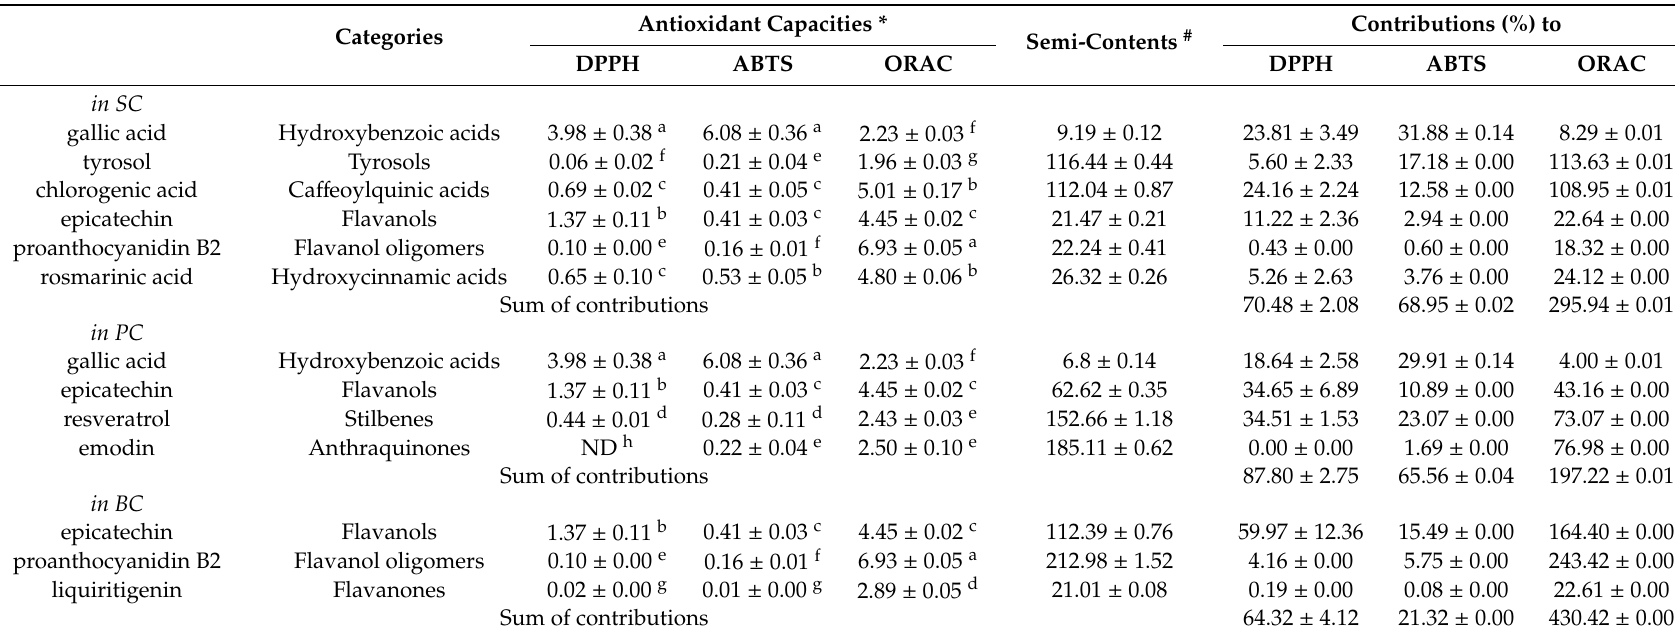
Table 2. Antioxidant capacities of nine selected phenolic compounds assessed with DPPH, ABTS, and ORAC